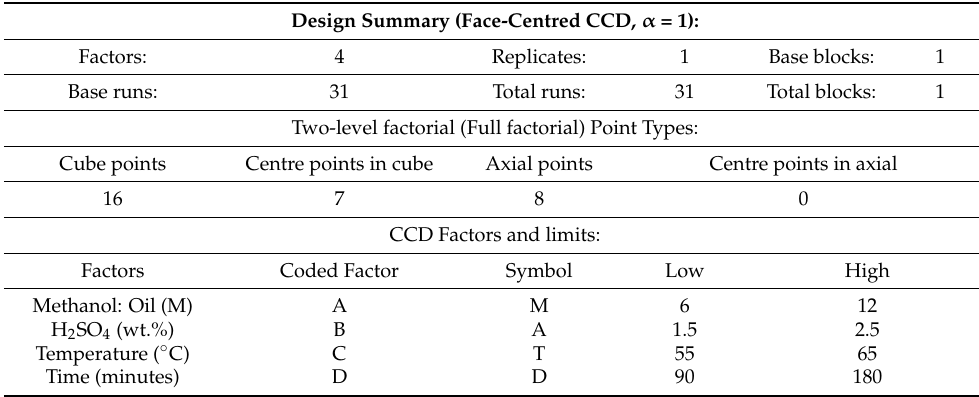
Table 7. Coded and un-coded values of levels and factors (WCO esterification).